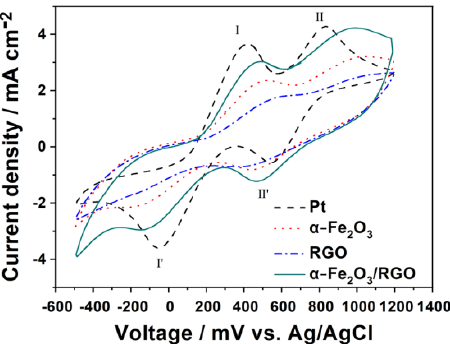
Figure 5. Cyclic voltammograms of α -Fe 2 O 3 /RGO, α -Fe 2 O 3 , RGO, and Pt CEs at a scan rate of 100 mV s − 1 .